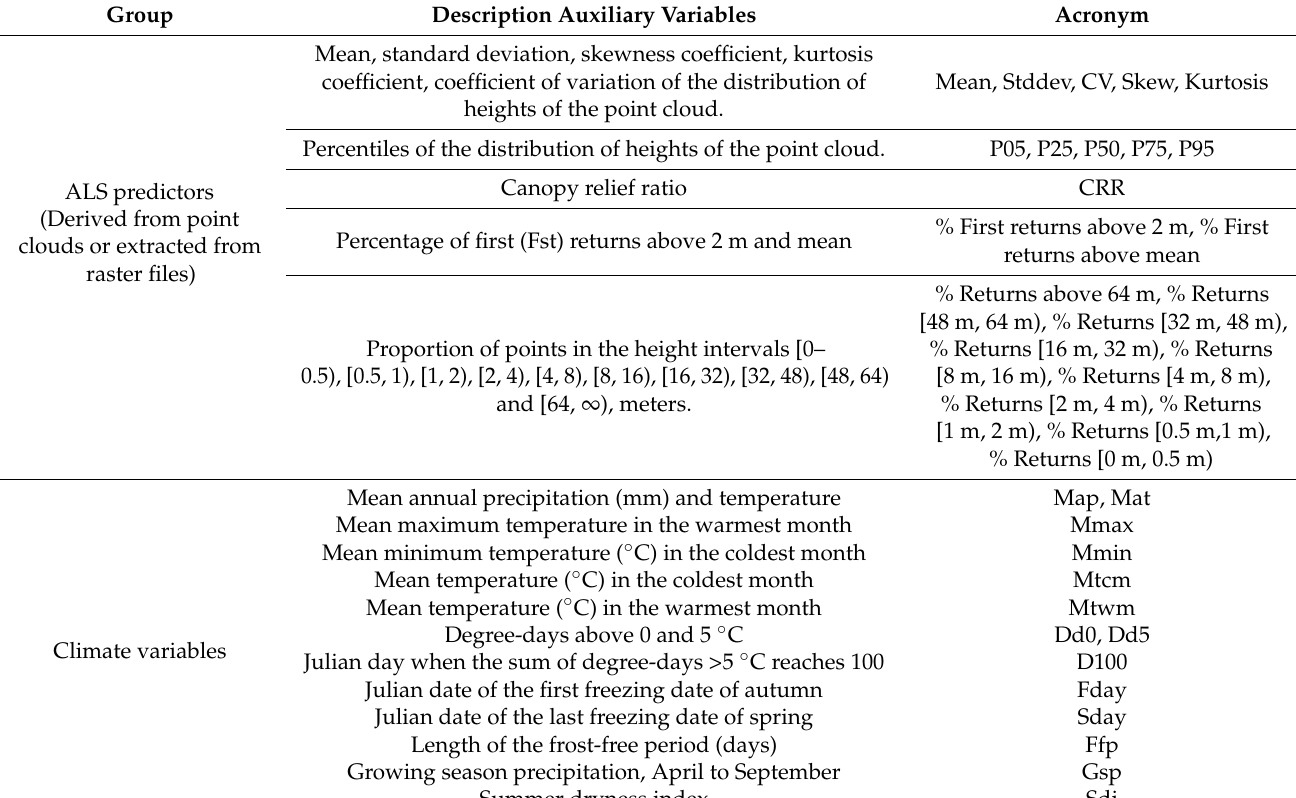
Table 2. Sets of candidate predictors used in the